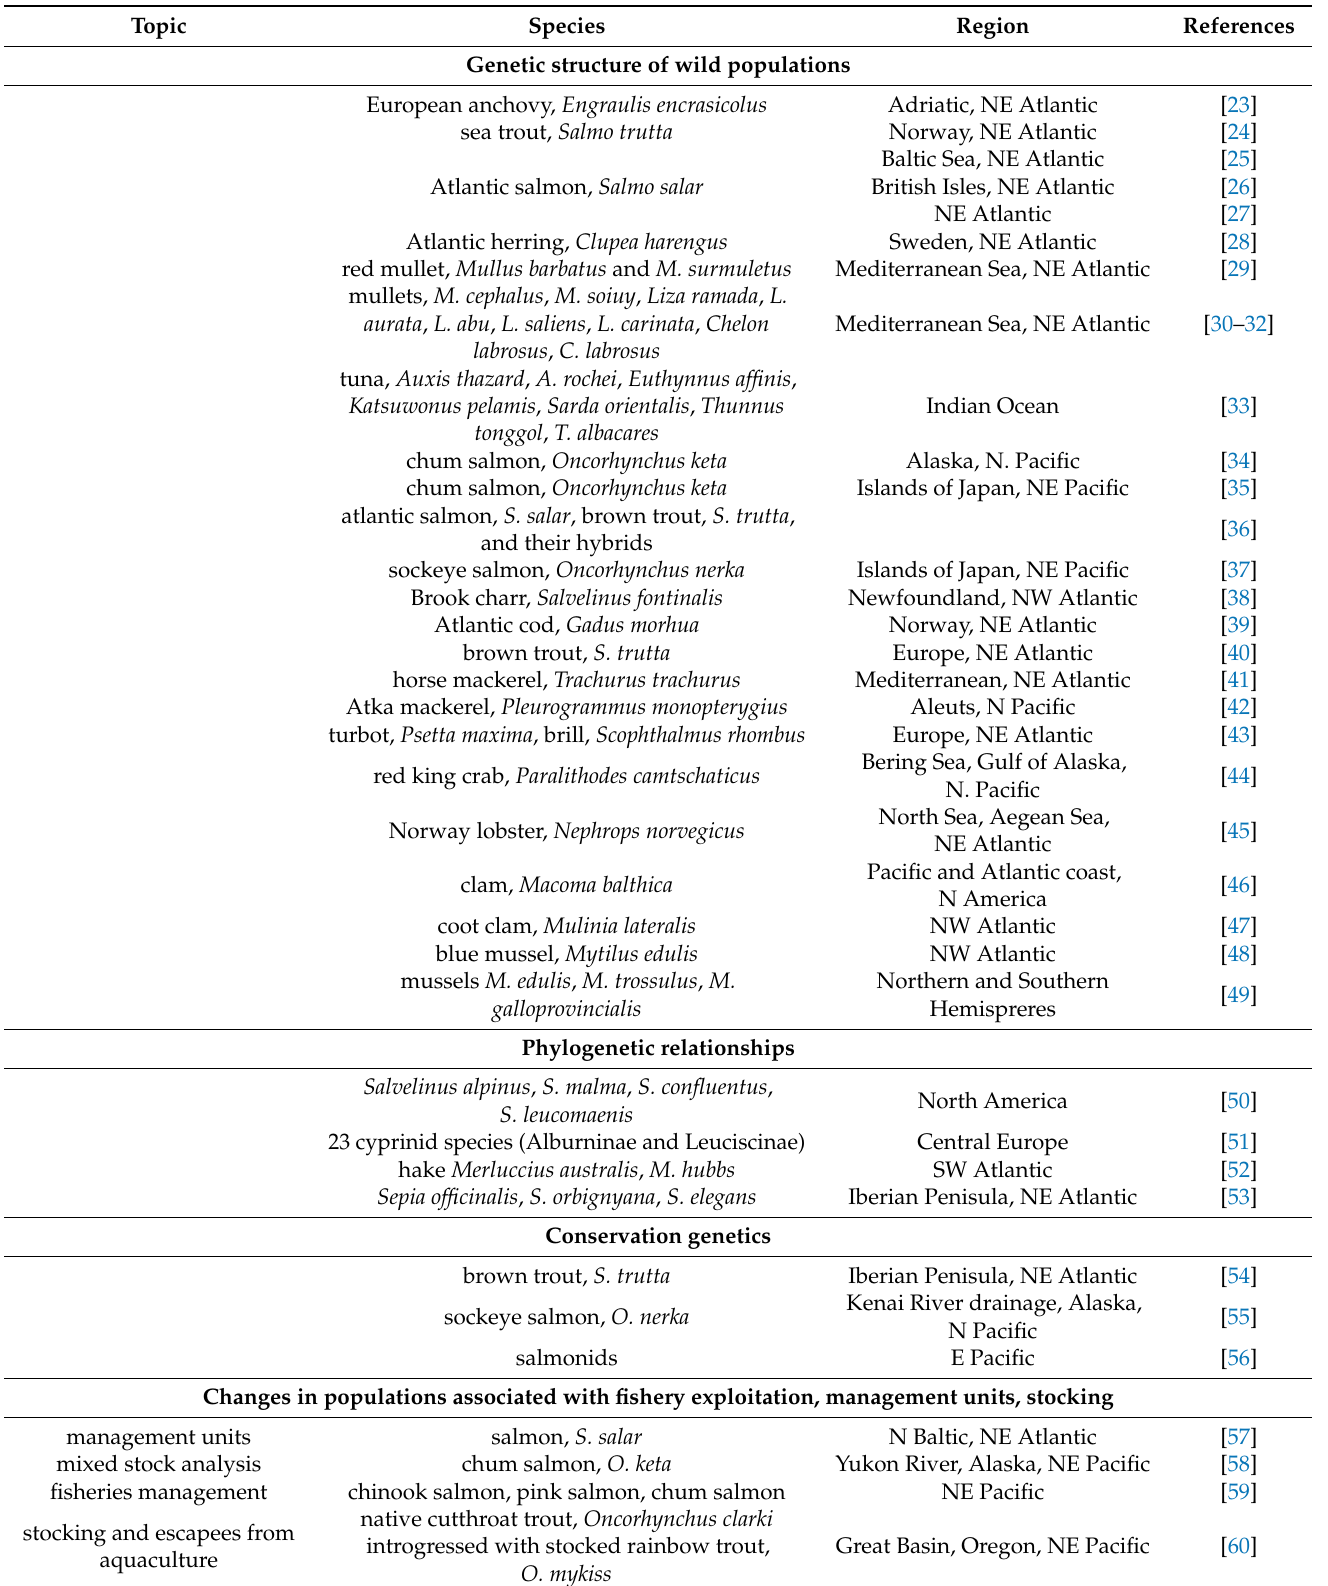
Table 1. Examples of applications of protein allozymes in studies of aquatic